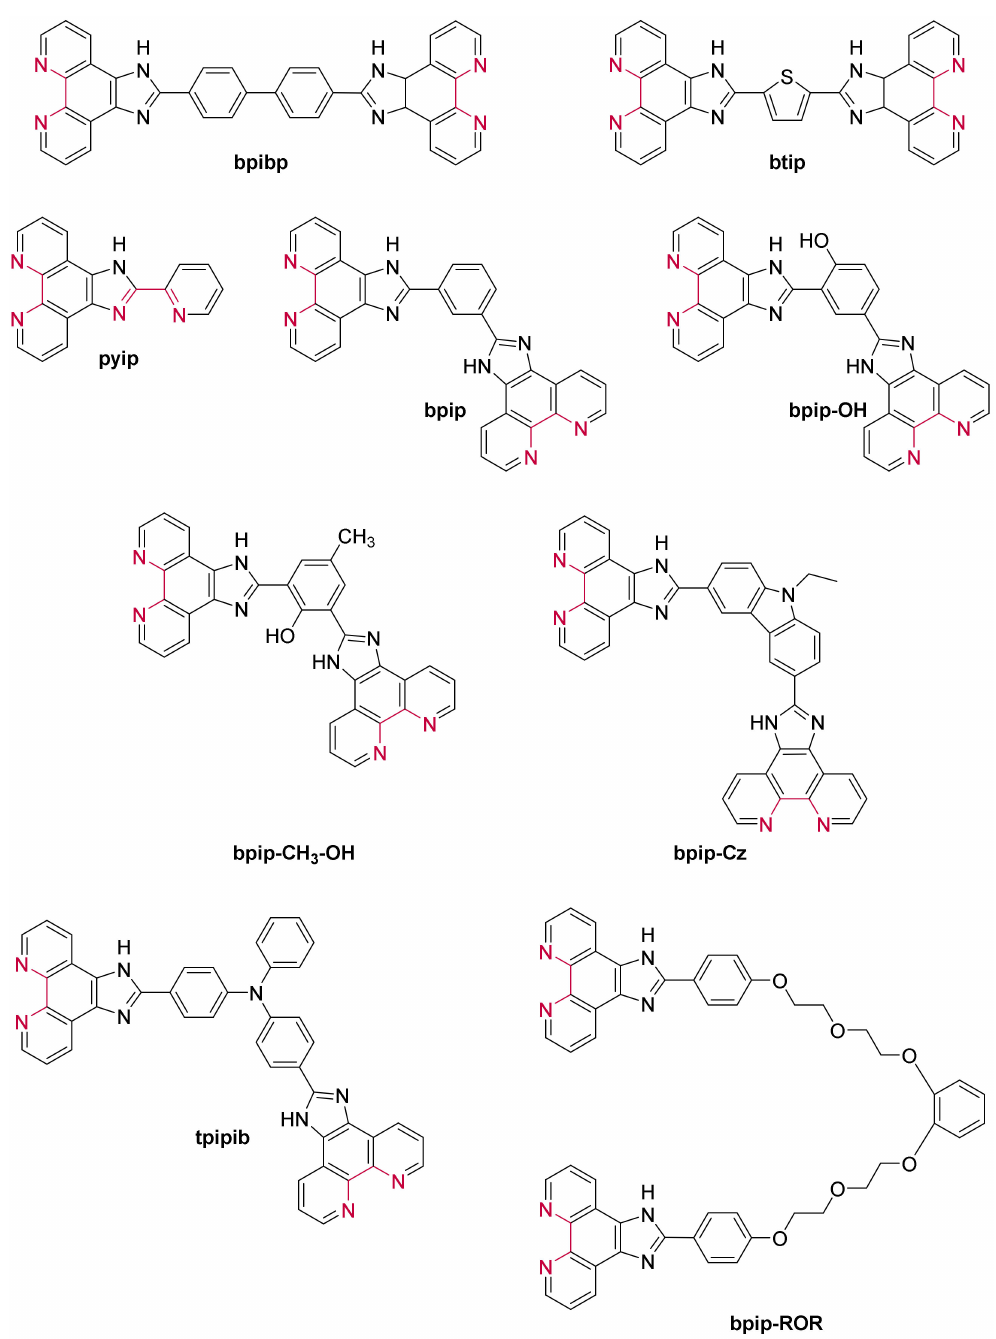
Figure 28. Structure of imidazo-phenanthroline ligands used to form dinuclear ruthenium(II) com- plexes studied in presence of